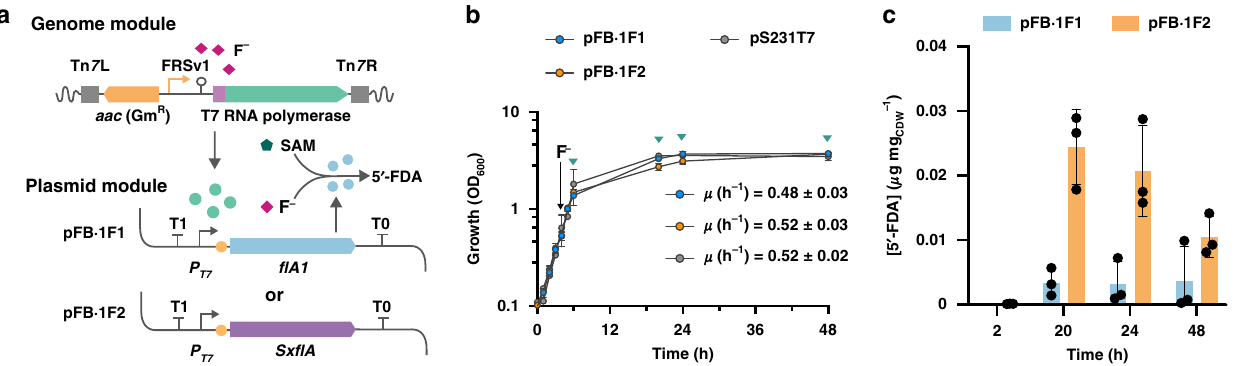
Fig. 3 In vivo bio fl uorination in engineered P . putida . a Scheme of the FRS-T7 RNA polymerase circuit controlling the expression of the two fl uorinases fl A1 and Sx fl A in plasmid modules. b Growth curves of P. putida KT2440::FRS-T7RNAP containing the plasmids described in ( a ), compared to the growth of P. putida KT2440::FRS-T7RNAP transformed with an empty vector (pSEVA231). The timing of F − addition to the cultures is indicated with a black arrow. Green arrows indicate the points when cultures were harvested to test 5 ′ -FDA biosynthesis. Mean values and standard deviations of the speci fi c growth rates ( μ ) after the addition of F − of each construction are shown in the plot. Error bars correspond to standard deviations of three biological replicates. c Intracellular 5 ′ -FDA concentration after 2, 20, 24, and 48 h of induction of the synthetic circuit with NaF. Data are presented as mean values and error bars correspond to standard deviations of three different biological replicates. CDW cell dry weight. Source data underlying Fig. 3b, c are provided as a Source Data fi